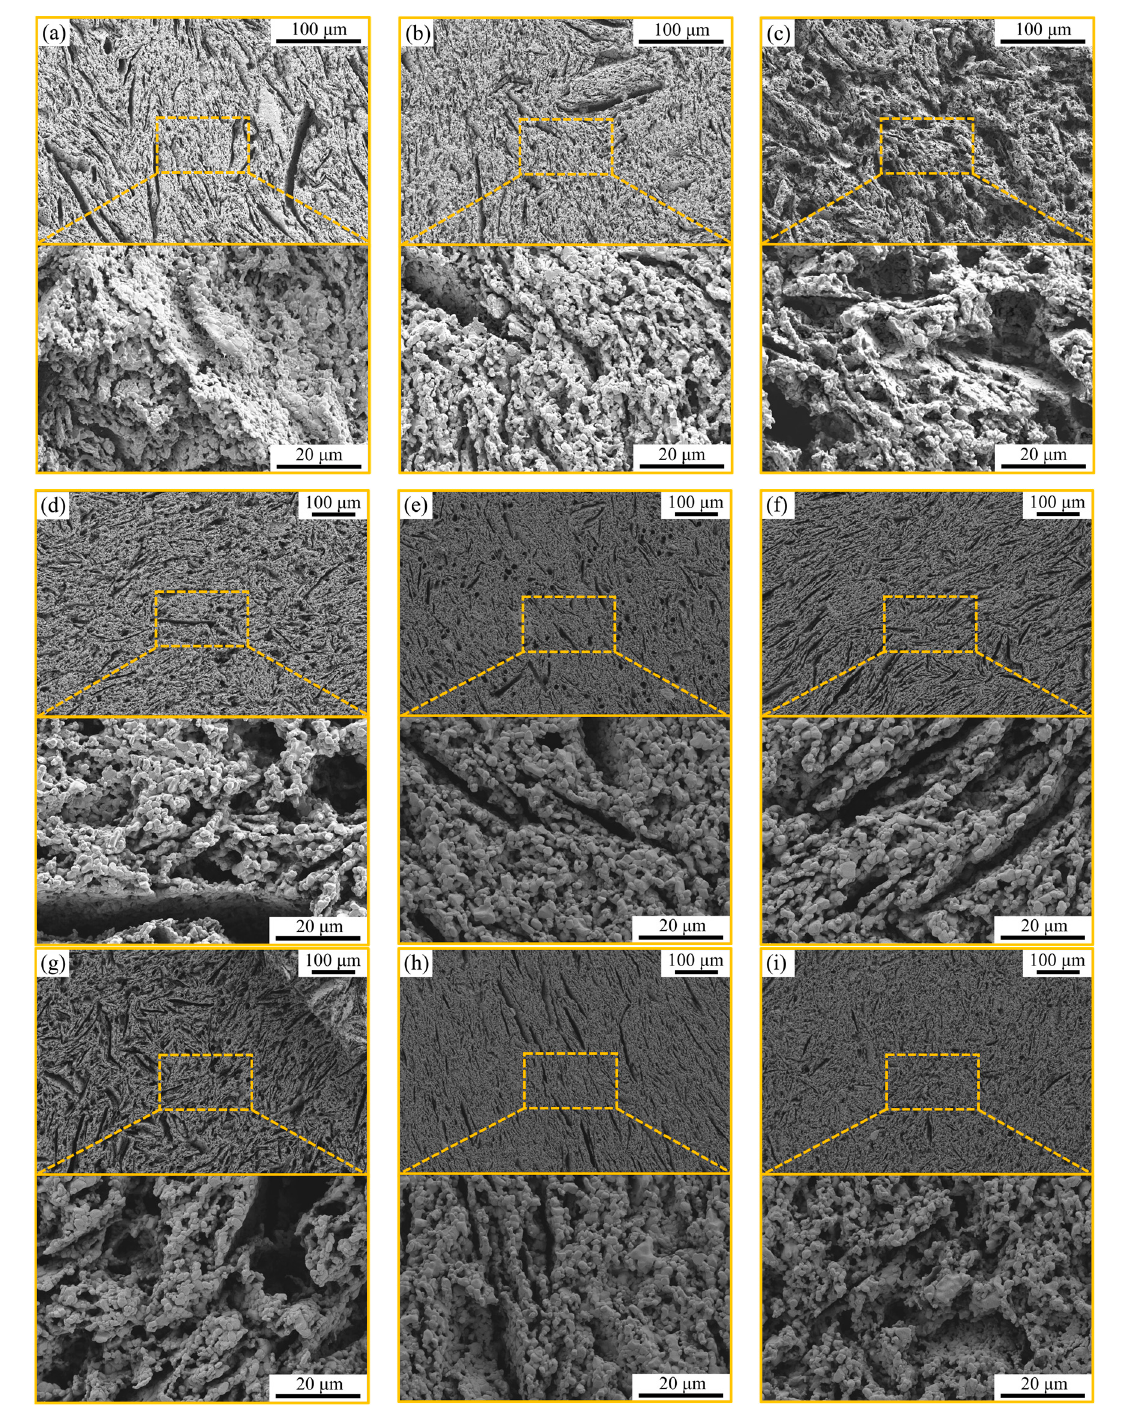
Figure 6. Scanning electron microscopy (SEM) images of porous alumina samples with 70 vol.% pore-forming agents. ( a ) 90 μ m CF:Graphite = 3:7; ( b ) 150 μ m CF:Graphite = 3:7; ( c ) 200 μ m pore-forming agents. ( a ) 90 µ m CF:Graphite = 3:7; ( b ) 150 µ m CF:Graphite = 3:7; ( c ) 200 µ m CF:Graphite = 3:7; ( d ) 90 μ m CF:Graphite = 5:5; ( e ) 150 μ m CF:Graphite = 5:5; ( f ) 200 μ m CF:Graphite CF:Graphite = 3:7; ( d ) 90 µ m CF:Graphite = 5:5; ( e ) 150 µ m CF:Graphite = 5:5; ( f ) 200 µ m = 5:5; ( g ) 90 μ m CF:Graphite = 7:3; ( h ) 150 μ m CF:Graphite = 7:3; ( i ) 200 μ m CF:Graphite = 7:3. CF:Graphite = 5:5; ( g ) 90 µ m CF:Graphite = 7:3; ( h ) 150 µ m CF:Graphite = 7:3; ( i ) 200 µ m CF:Graphite =